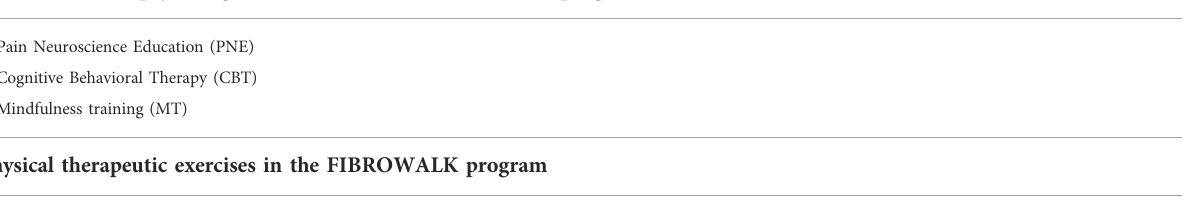
TABLE 1 Outline of the FIBROWALK program (with FIBRO-Out and FIBRO-On speci fi cations). Educational and psychological contents in the FIBROWALK